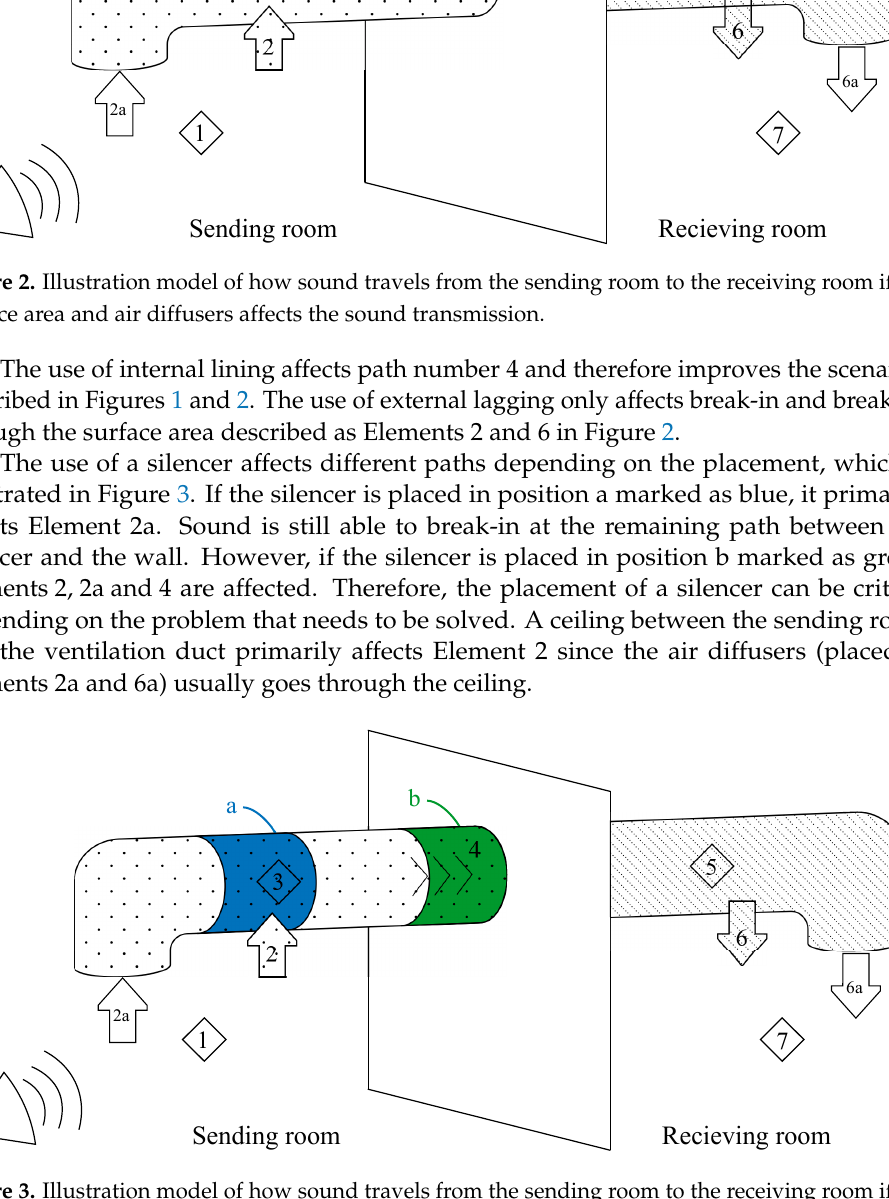
Figure 3. Illustration model of how sound travels from the sending room to the receiving room if the surface area and air diffusers affects the sound transmission. Two areas on the ventilation duct in the sending room are marked with blue and green colors together with the letters a and b that describe different areas for acoustical